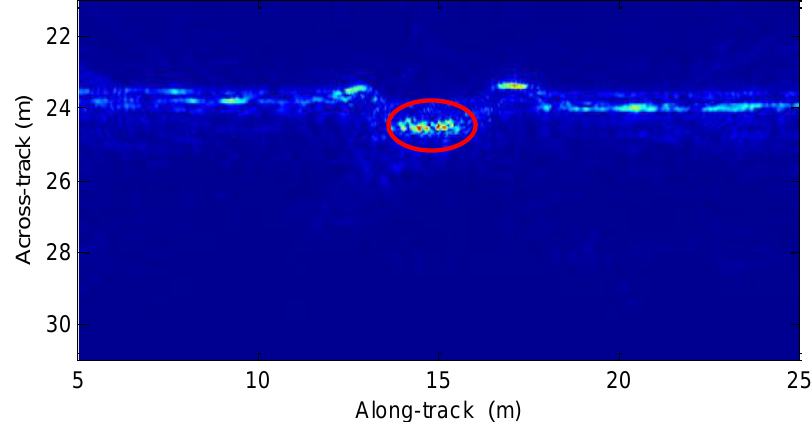
Along-track （ m) Figure 22. Imaging result without the MC. Figure 22. Imaging result without the